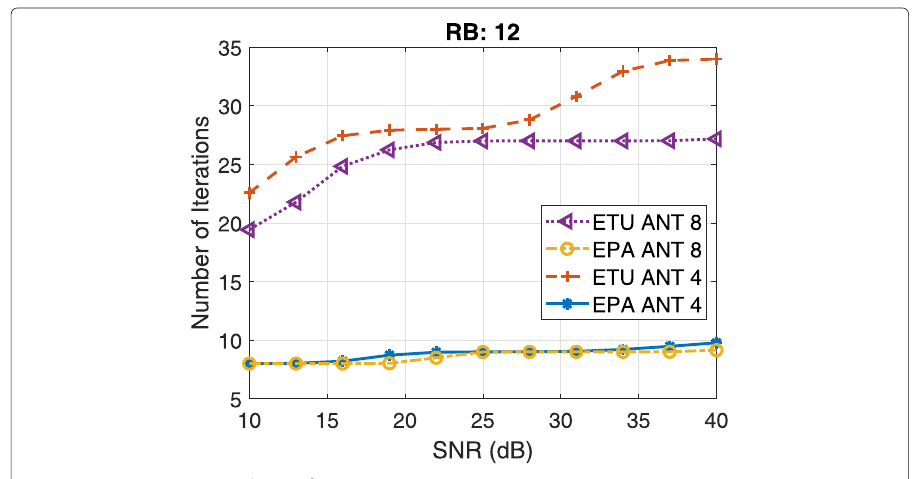
Fig. 12 Computation complexity of